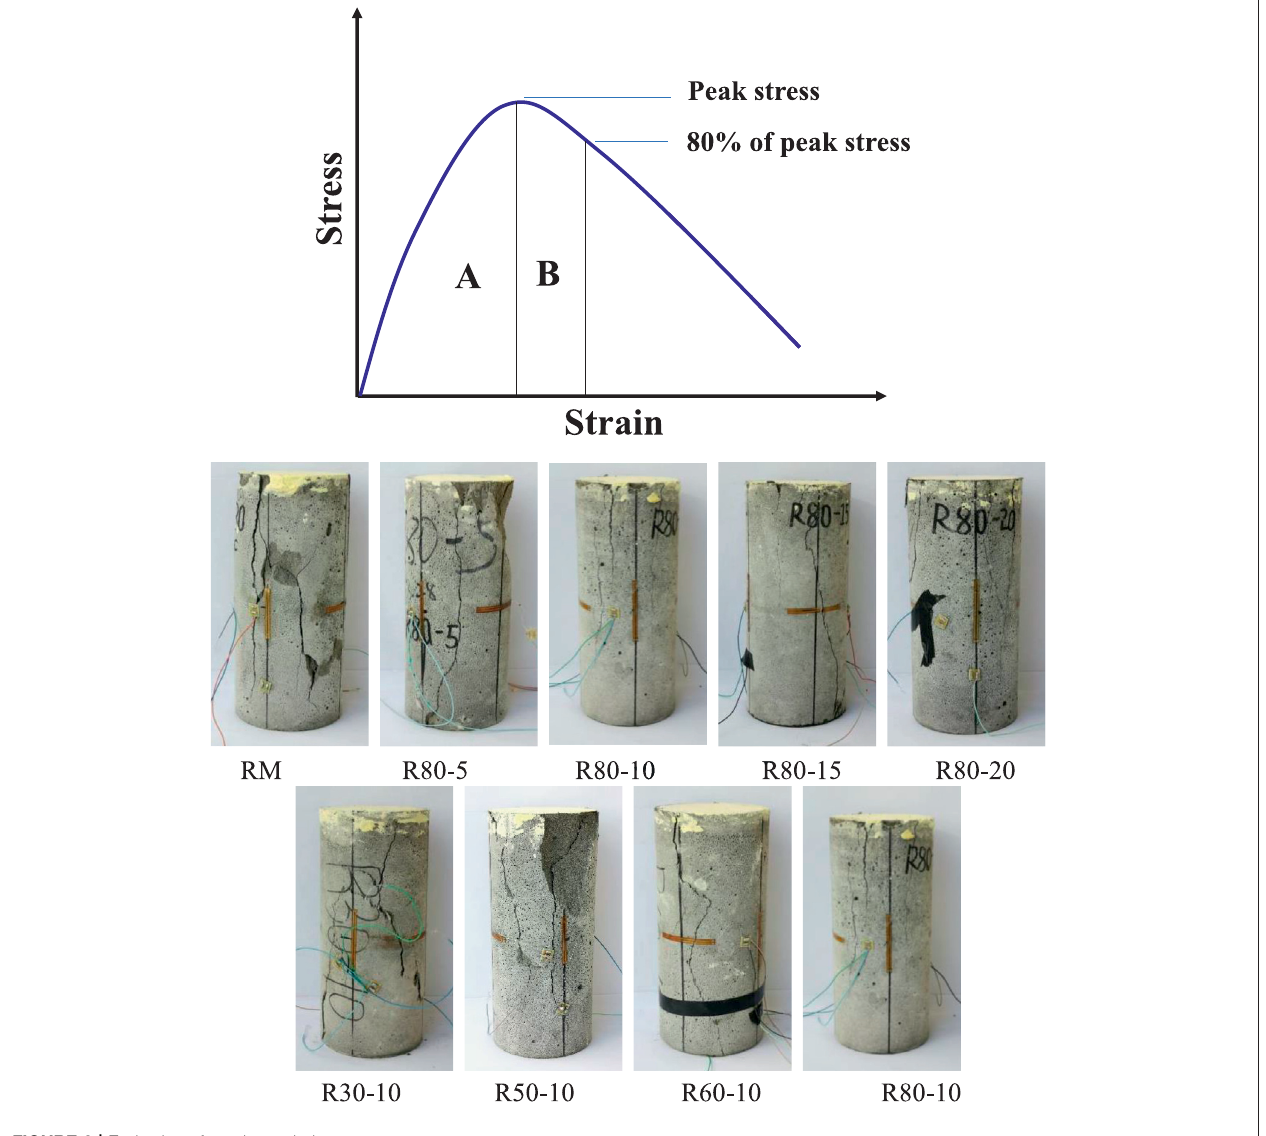
FIGURE 9 | Evaluation of toughness